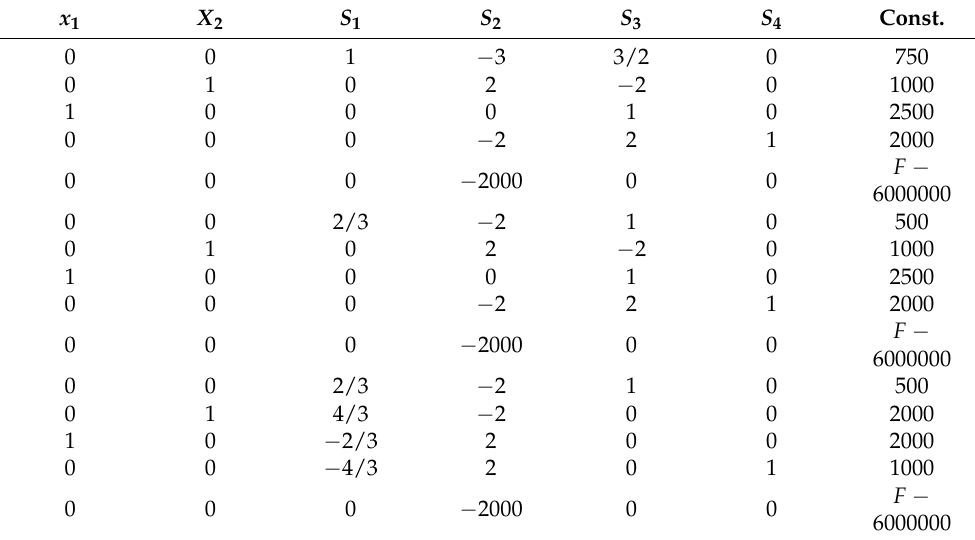
Table 2. Value of function